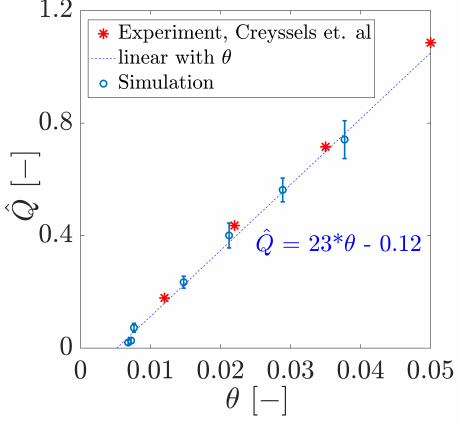
Figure 3. Rescaled saturated flux ˆ Q as a function of the Shields number θ